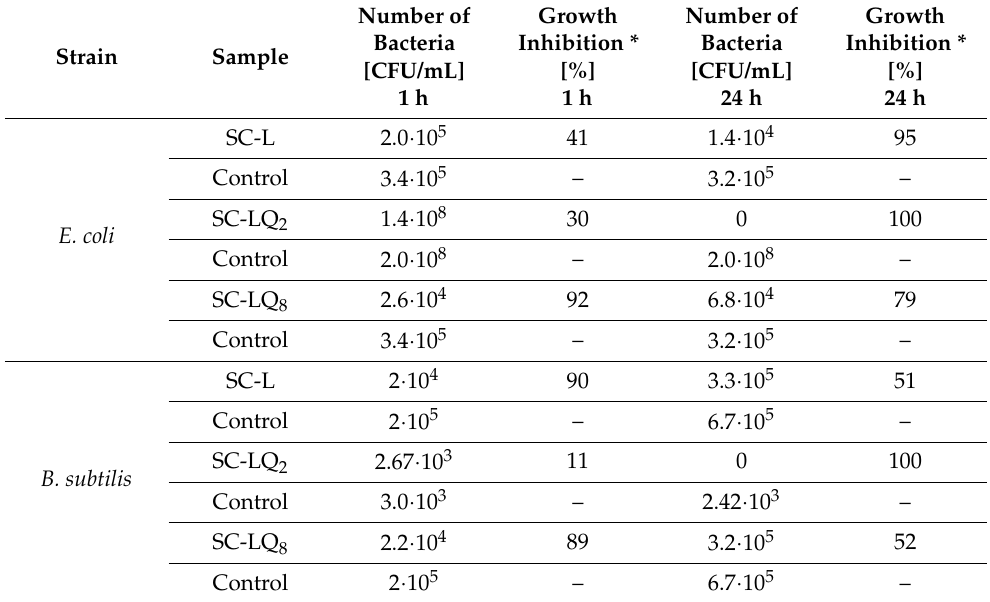
Table 2. Growth inhibition of Bacillus subtilis and Escherichia coli by star copolymer layers after 1 and 24 h of